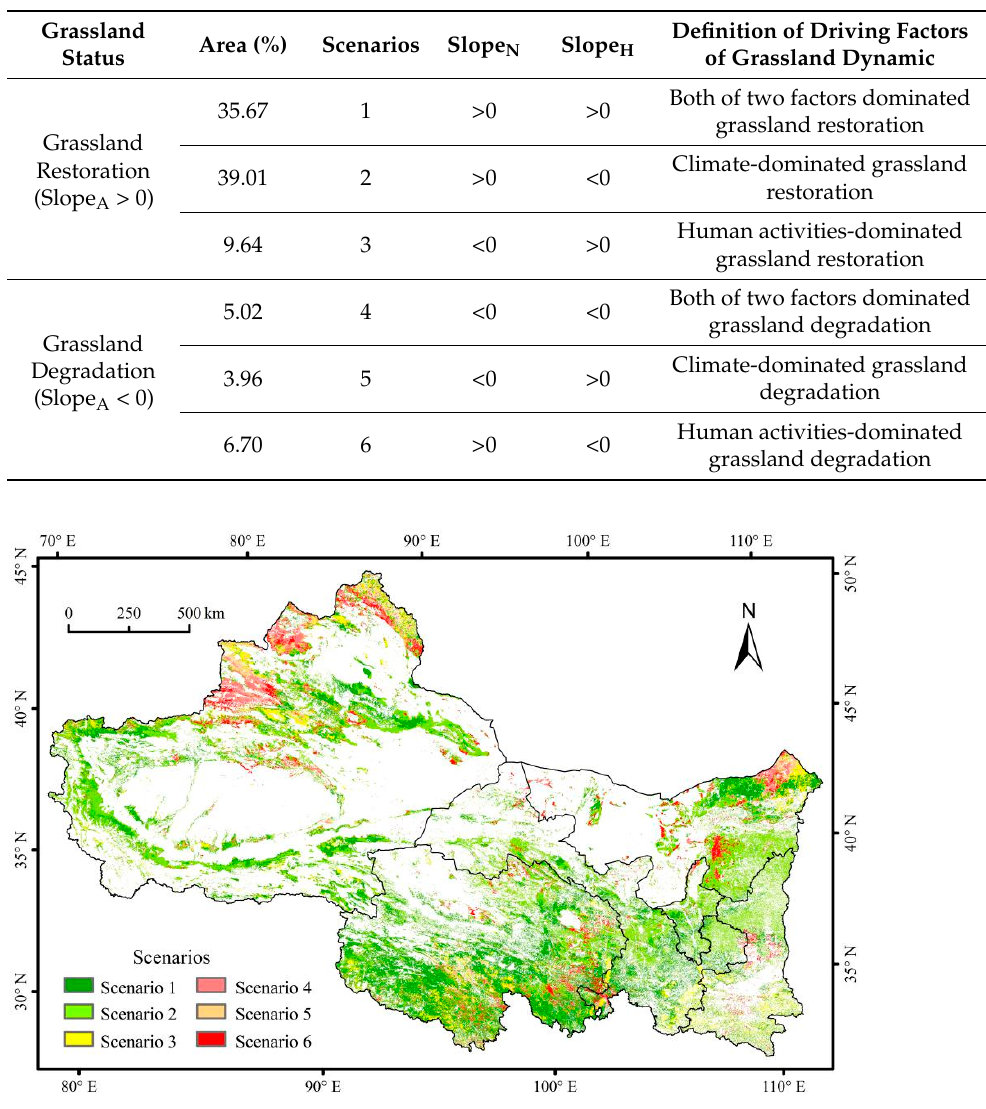
Figure 14. Relative effects of climate change and human activities on grassland ANPP.